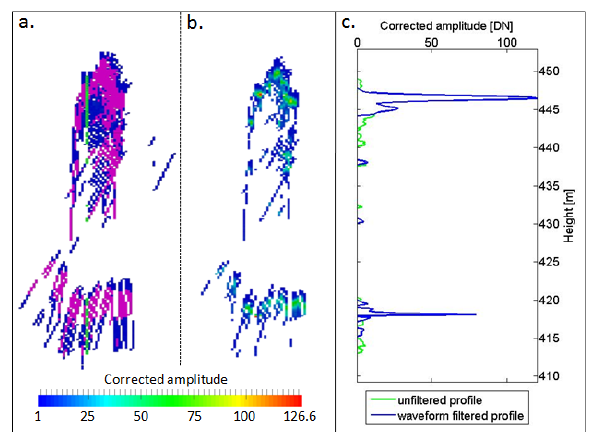
Figure 13. Results of waveform filtering: vertical slice of unfiltered and filtered voxel space overlaid (a), vertical slice of filtered voxel space coloured by attributes (b), profiles of a column (c)